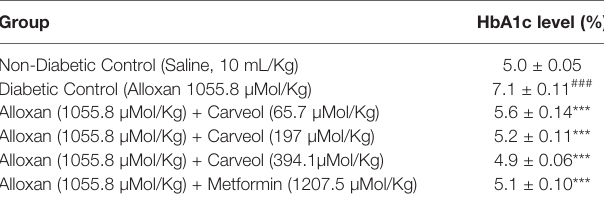
TABLE 4 | Effect of carveol at different doses and metformin on glycosylated hemoglobin A1C (HbA1C) in alloxan-induced diabetic rats. Group HbA1c level (%) Non-Diabetic Control (Saline, 10 mL/Kg)